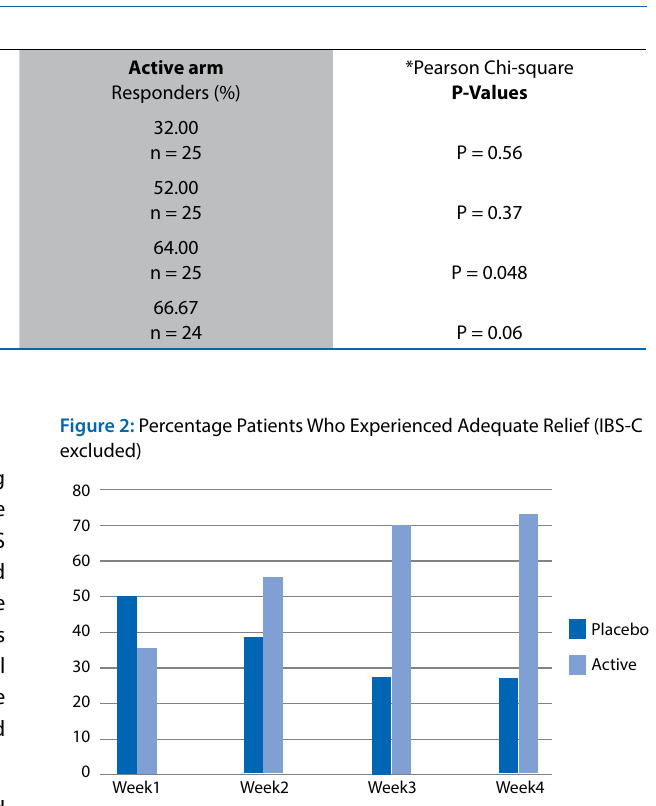
* IBS-C data excluded; N = 34